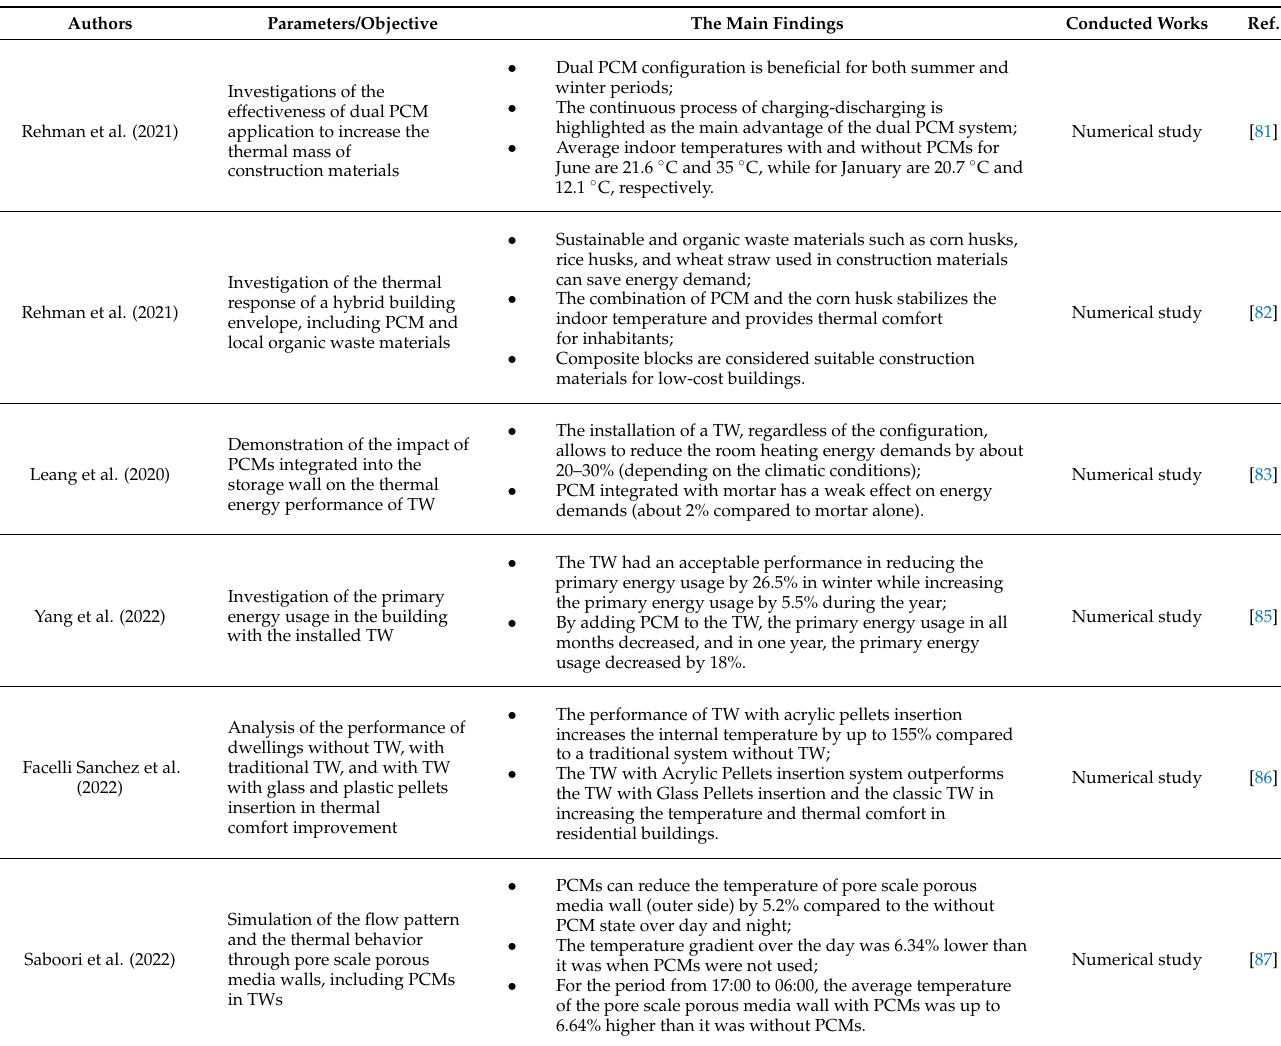
Table 3. The summary of works focused on the Trombe walls with incorporated